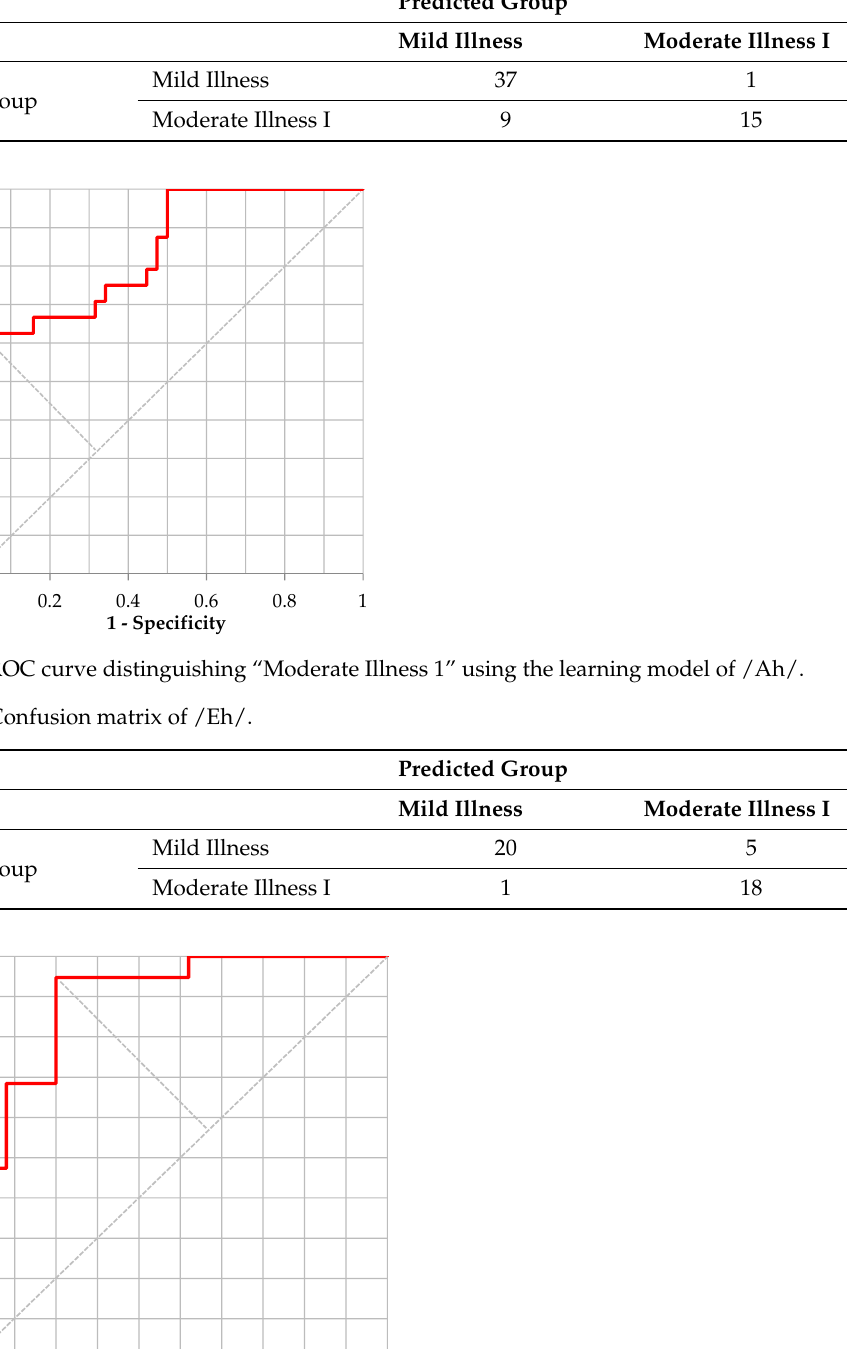
Table 9. Confusion matrix of /Ah/.